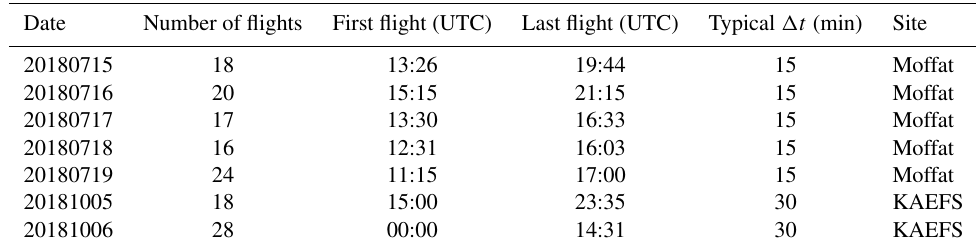
Figure 2. Location and domain size for the LAPSE-RATE (a) and Flux Capacitor (b) campaigns. During LAPSE-RATE, OU was deployed at both the Saguache Municipal Airport and the Moffat School; however, only the Moffat data will be analyzed in this study (satellite images © 2018 Google). Table 1. Summary of flights at the Moffat School and KAEFS. In total, 141 flights were used in the comparison. The fifth column lists the typical cadence of flights, typical (cid:49)t , which corresponds to the typical amount of time between